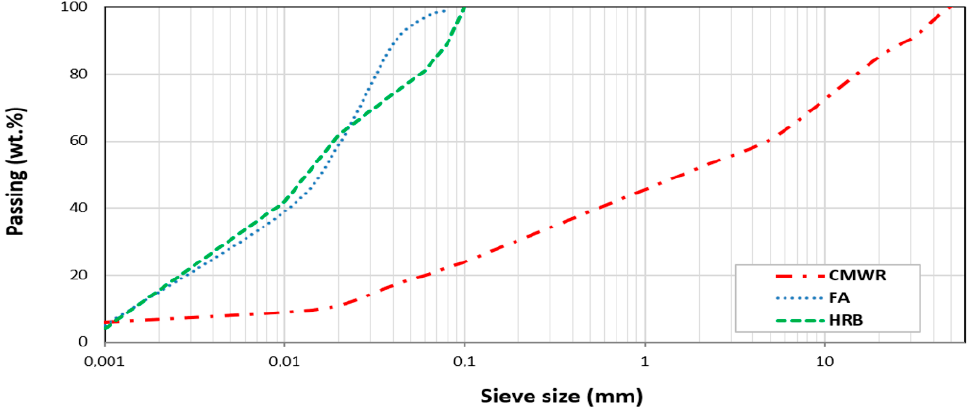
Figure 5. Grain size distribution curves of used materials.